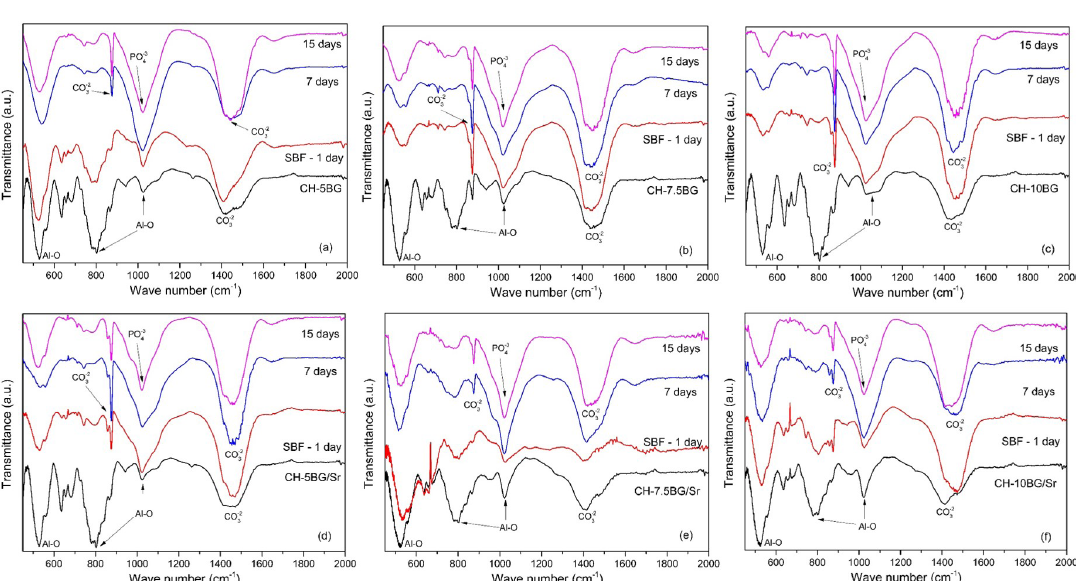
Figure 5. FTIR spectra for blends based on homogeneous calcium aluminate cement (CH) containing different contents of bioactive glass (BG) and 1 wt% strontium (Sr), without or with SBF treatment for 1, 7 and 15